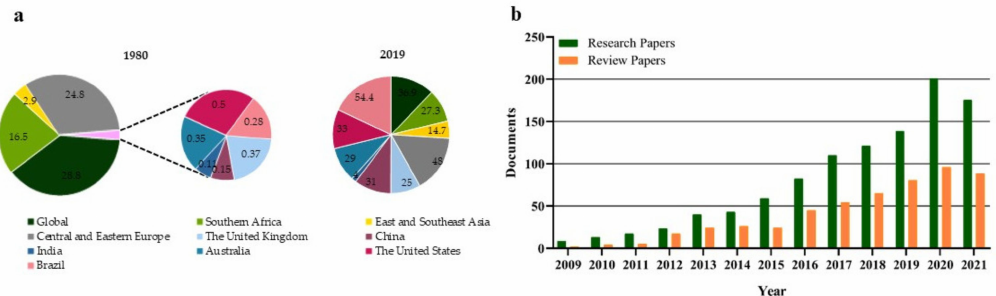
Figure 1. ( a ) The prevalence of overweight and obese adults increased in 1980 and 2019 in different regions and countries worldwide. The data come from Global Burden of Disease (GBD), a research program on the burden of disease that evaluates mortality and disability due to major disease, injury, and risk factors. ( b ) A number of articles were published on the anti-obesity effects of food products affecting gut microbiota over the period 2009–2021, according to the Web of Science Database (last accessed 25 December 2021, documents search: “food AND obesity AND gut microbiota”).